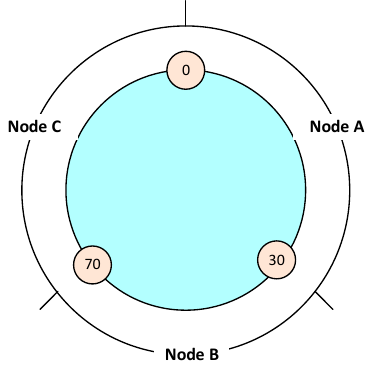
Figure 8. The correspondence of the data blocks, nodes, and hash spaces.